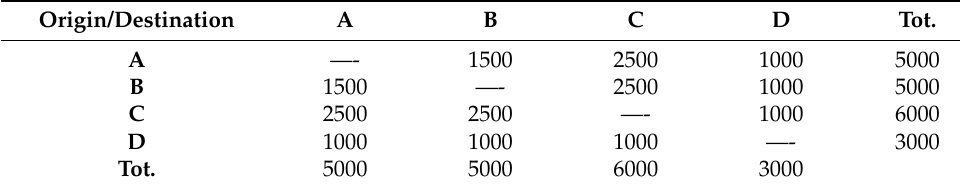
Tot. 5000 5000 6000 3000